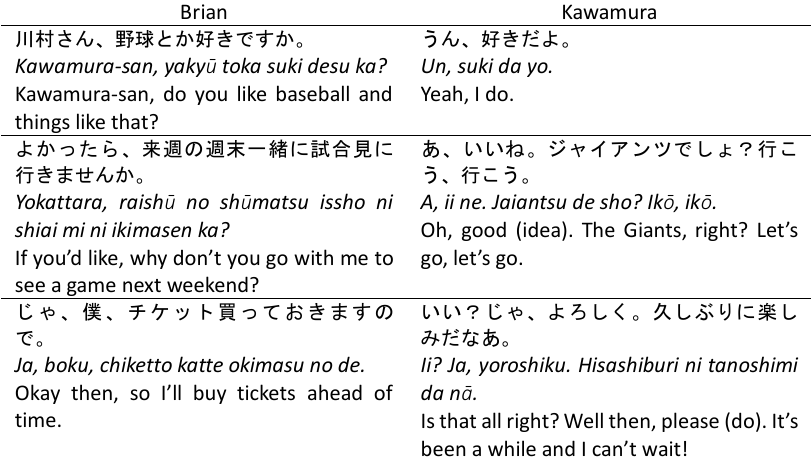
Table 2. A dialogue from ACT 10 Scene 1 from NihonGO